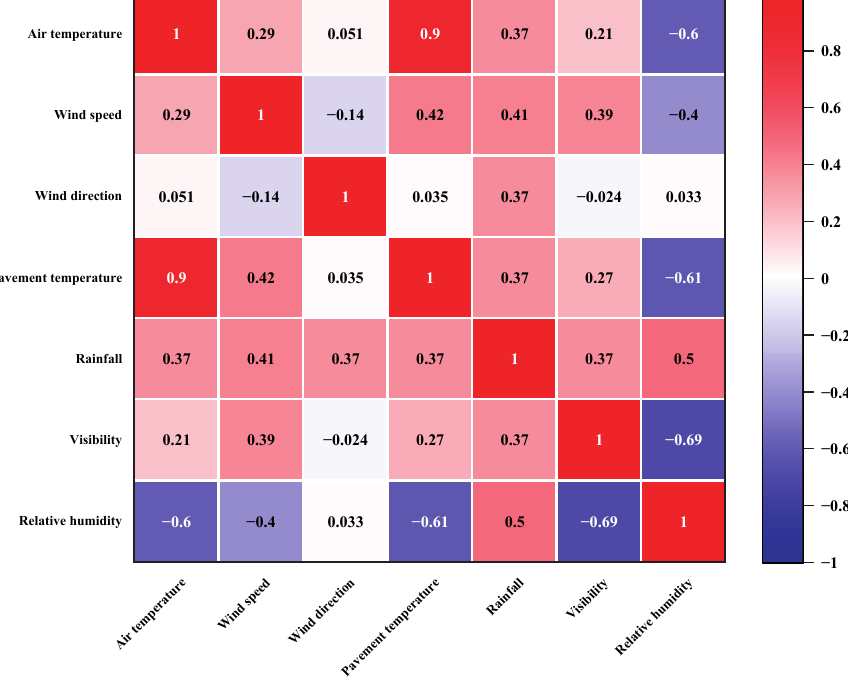
Figure 9. Correlation coefficients between pavement temperature and various meteorological fac ‐ tors.